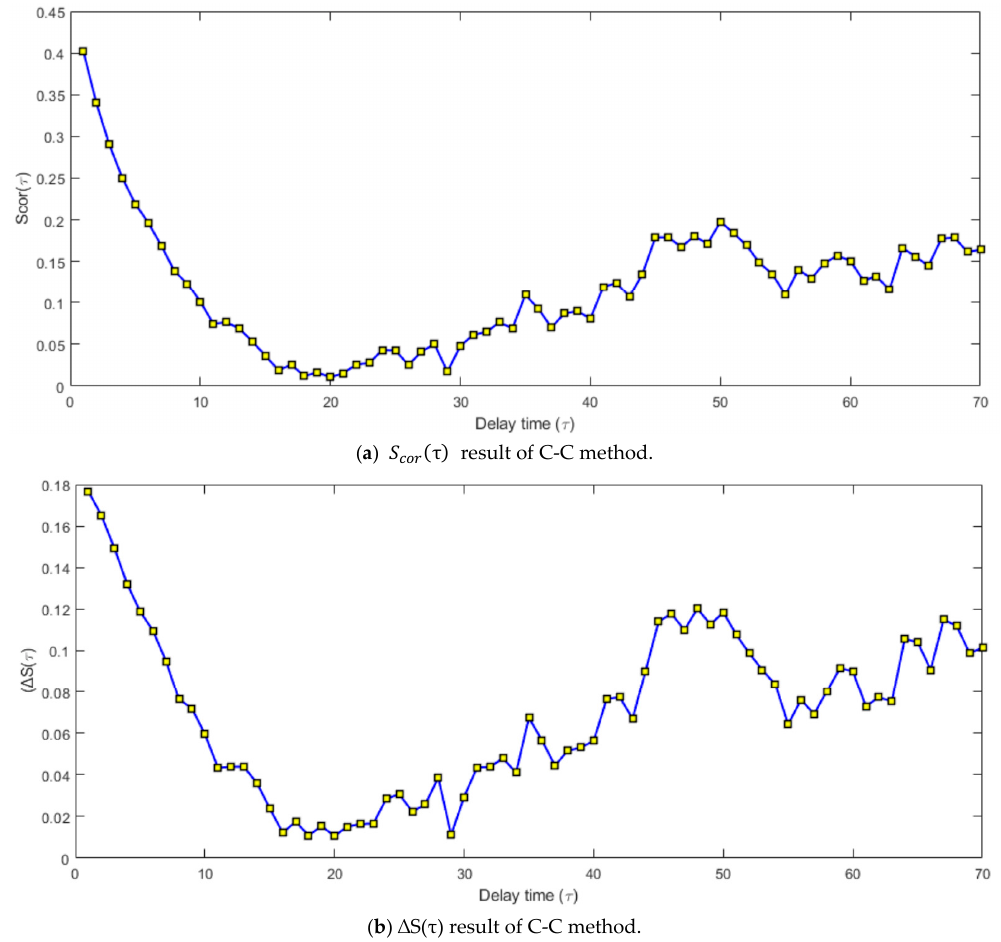
Figure 4. Results of PSR for H 2 time series samples from 23 May 2011 to 8 August 2012.